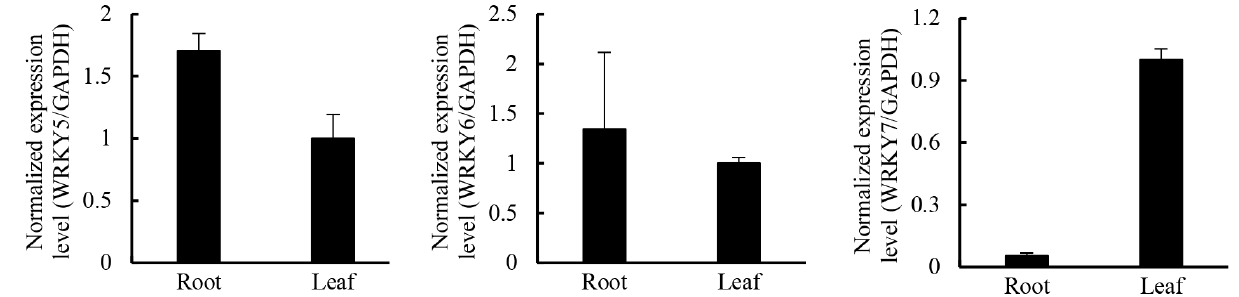
Figure 10. The expression pattern of three selected WRKY genes in roots and leaves in G. rigescens . Means ± SE; each qRT-PCR was biologically repeated three